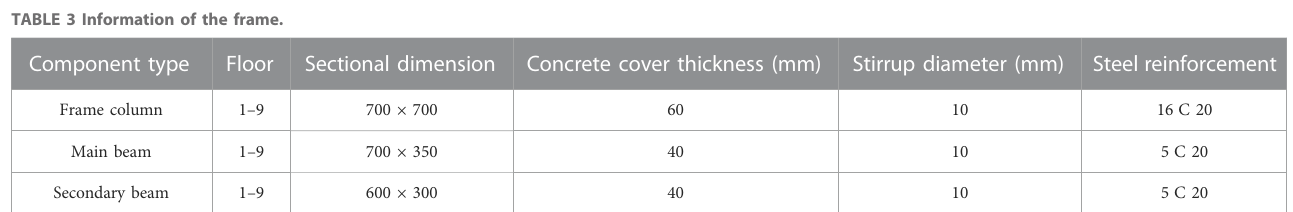
TABLE 3 Information of the frame.